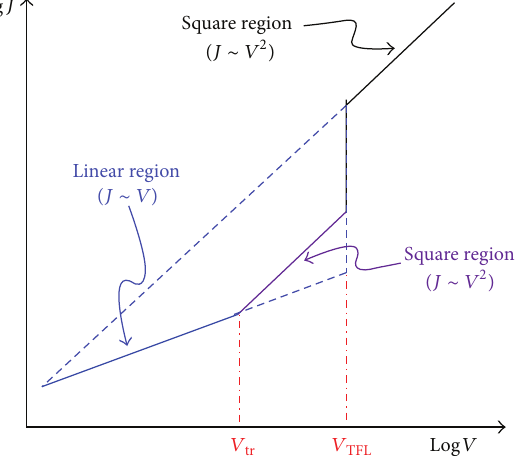
Figure 24: A typical current density-voltage ( 𝐼 - 𝑉 ) characteristic of space-charge-limited conduction current. 𝑉 tr is transition voltage. 𝑉 is trap-filled limit TFL